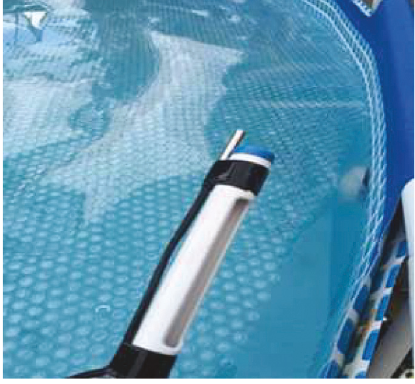
Figure 5: Speaker cords.